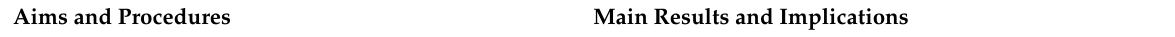
Table 1. Recently published articles on carotenoids from peach palm